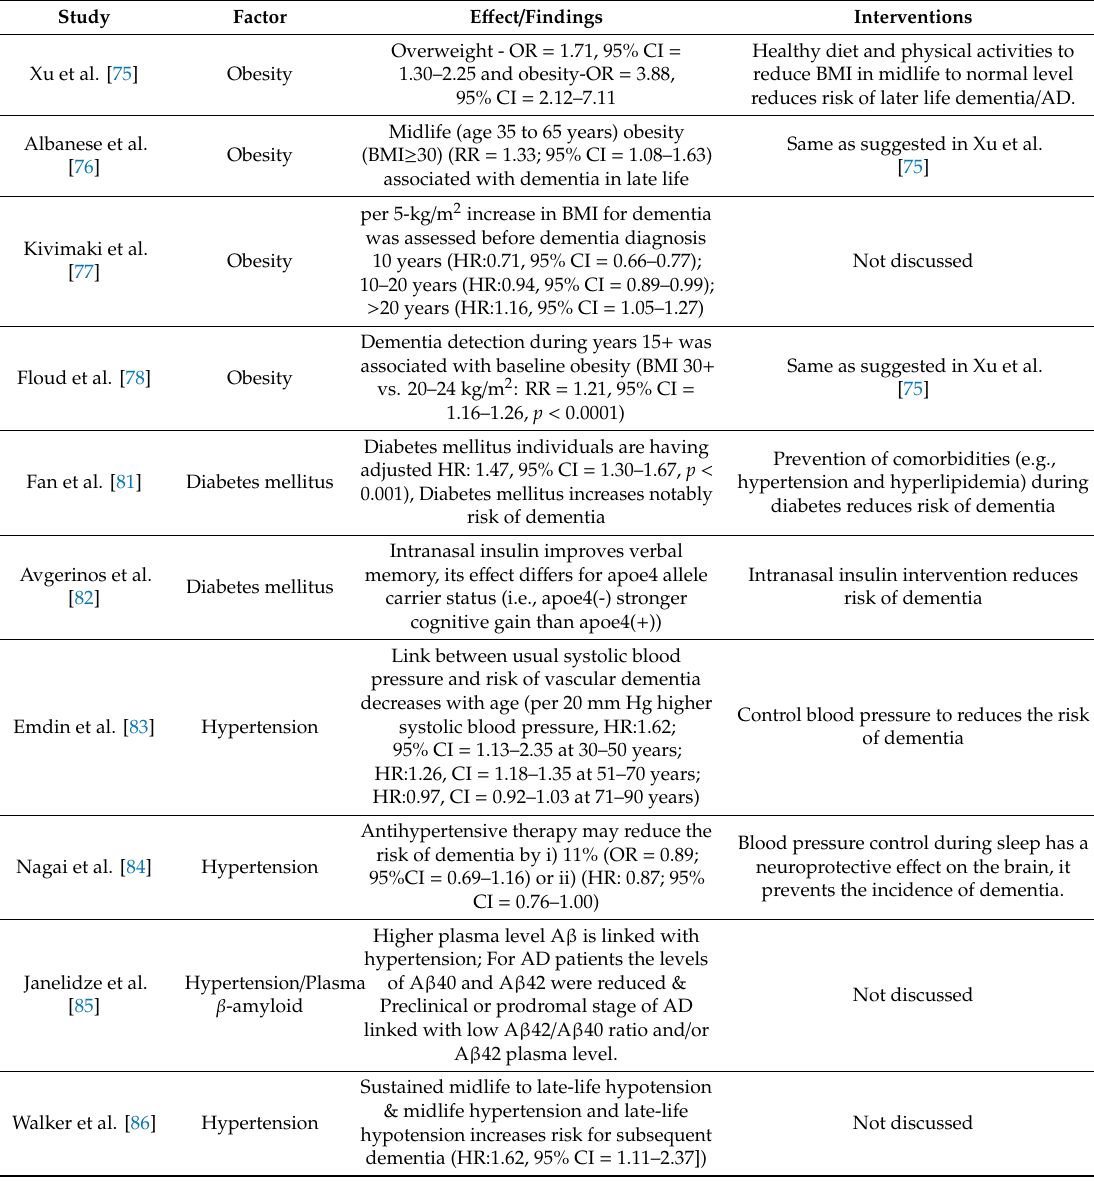
Table 3. Association of the obesity, diabetes mellitus and hypertension with the risk for development of dementia / Alzheimer’s